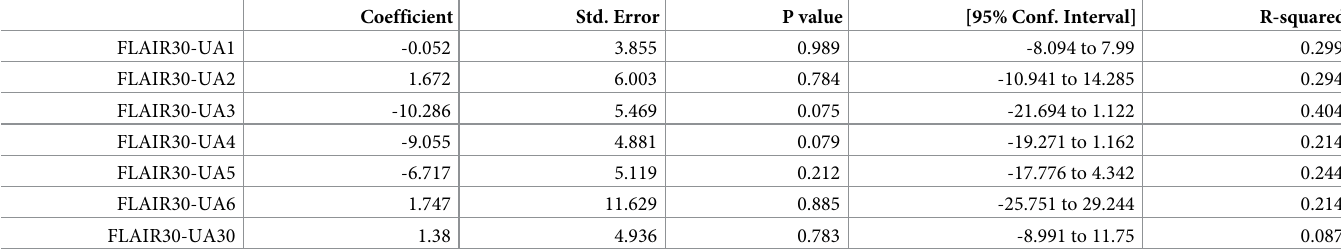
Table 5. Multivariable linear regression of FLAIR at day 30 on uric acid values during follow up, adjusted by sex, age and NIHSS score. UA = Uric